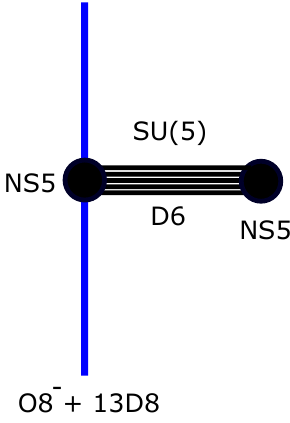
Figure 35 . Type IIA brane con(cid:12)guration for the SU(5) gauge theory with N AS = 1 ; N F =